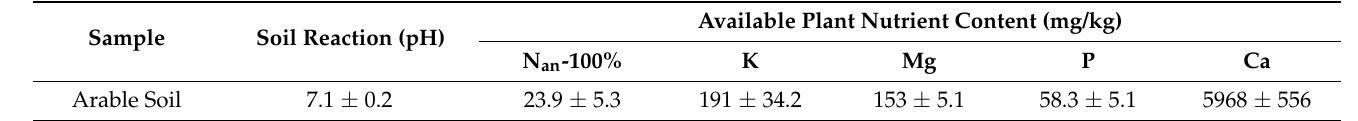
Table 1. Characteristics of arable soil from the experimental plot, average contents of available plant nutrients.